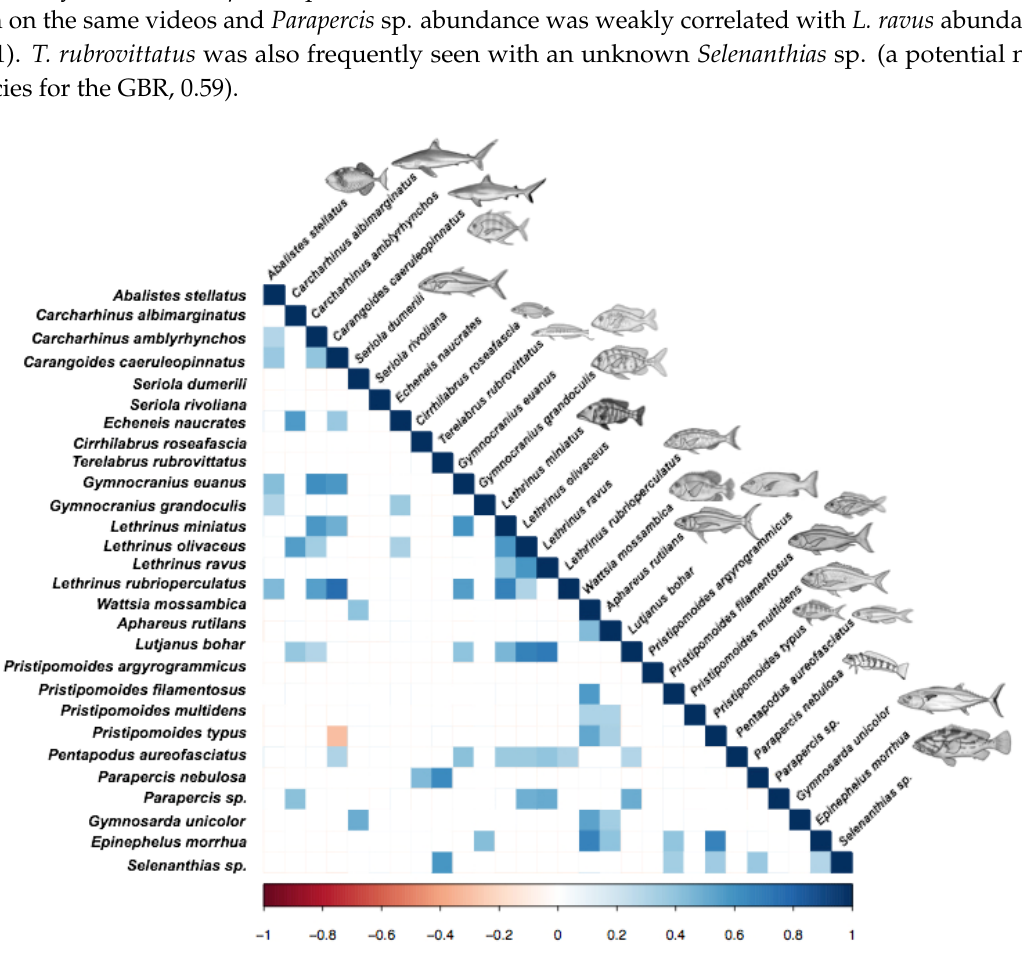
Figure 7. Species correlations of most frequently occurring 28 fish species from Baited Remote Underwater Video Station deployments on shelf-break reefs. Positive Pearson correlation values are depicted in blue and negative correlations in red (only significant correlations where p < 0.05 are depicted).